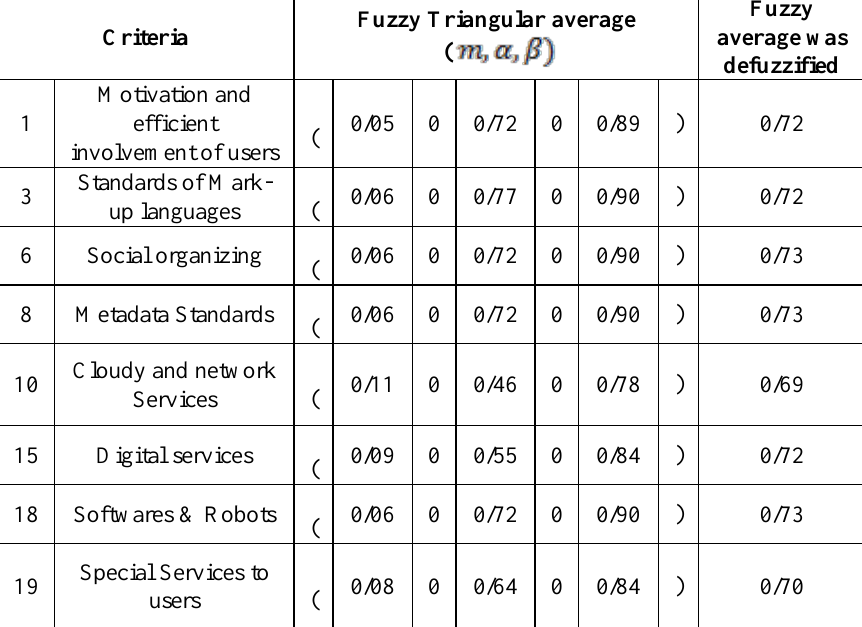
Table 8. Average of expert's points of view resulted from the third